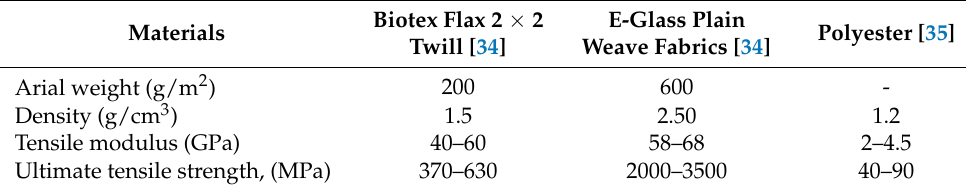
Figure 1. The fibres that are used to form the eco-hybrid composites. Table 1. Mechanical properties of Flax, E-Glass, and Polyester resin.